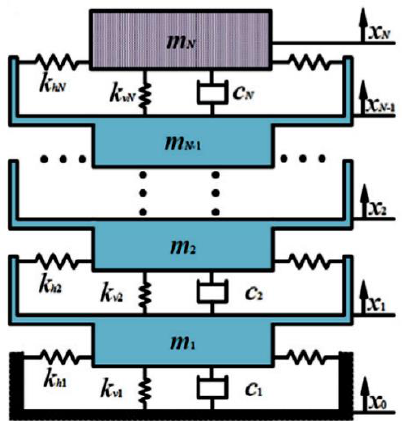
Figure 14. Bionic vibration isolation device based on a bird ’ s neck [63].